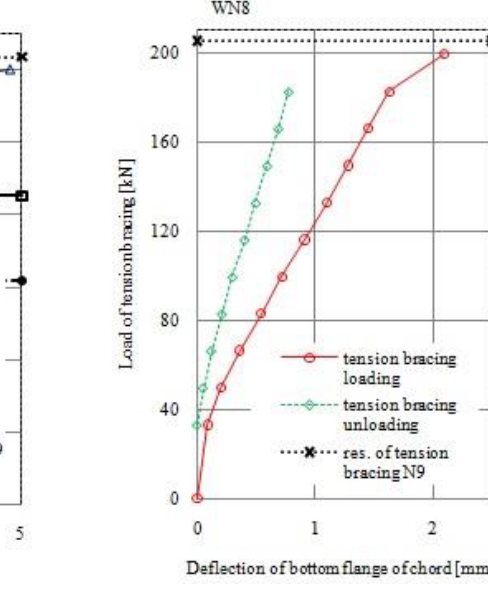
Figure 12: Load-deflection diagram for joint WN8 ( β = 0,8)